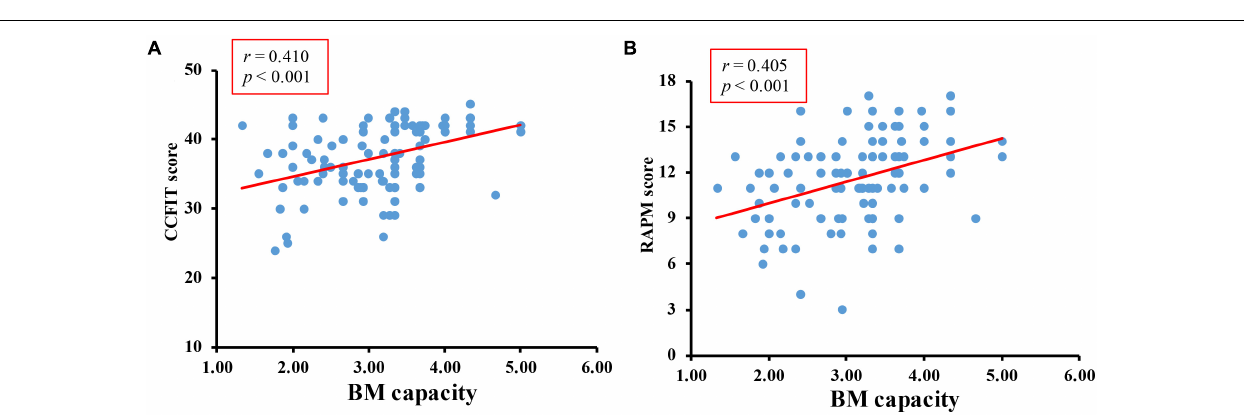
FIGURE 3 | Results of formal study. (A) The correlation between BM-WM capacity and CCFIT. (B) The correlation between BM-WM capacity and